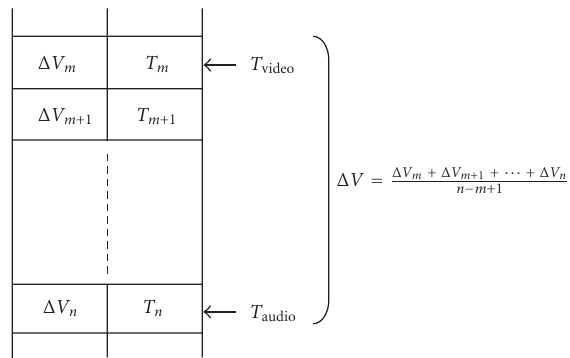
Figure 4: Average video rate of change calculation.